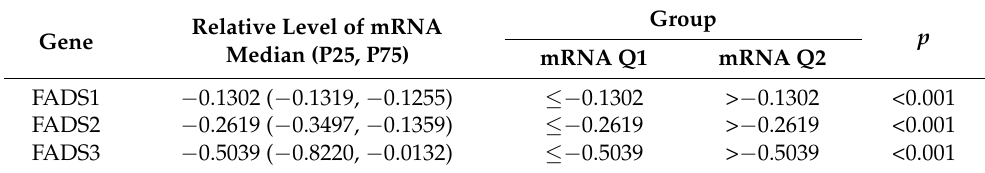
Table 4. Relative levels of mRNA and groups divided by expression of FADS